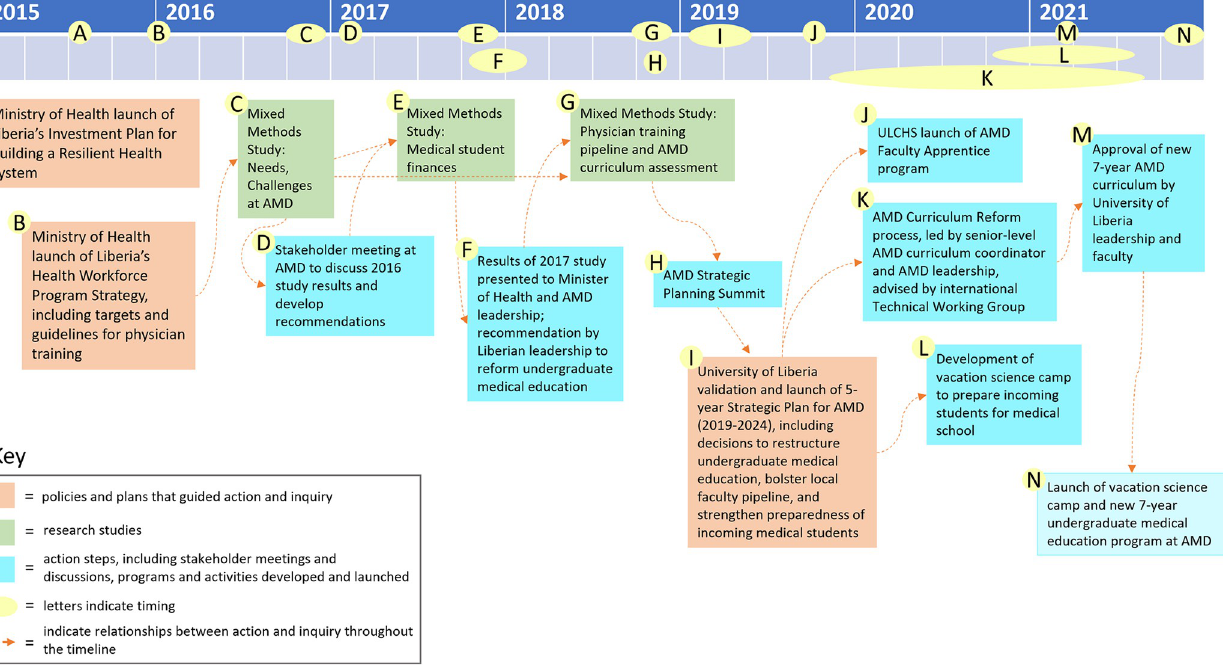
Fig 4. Timeline of action-inquiry to restructure medical education in